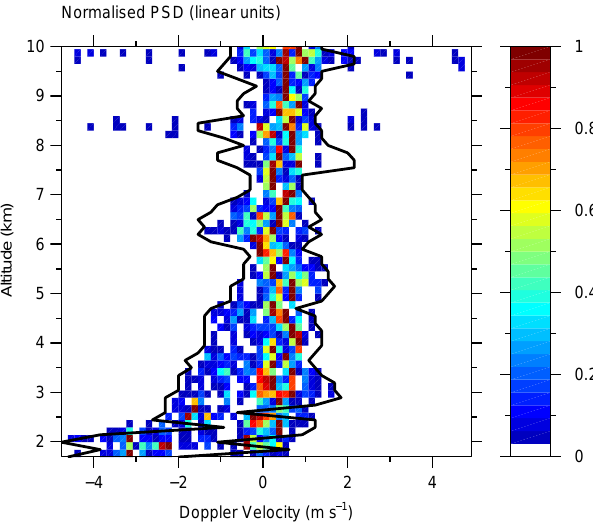
Fig. 5. Normalised Doppler power spectra for the vertical beam made at 15:00 UT on 14 June 2001.